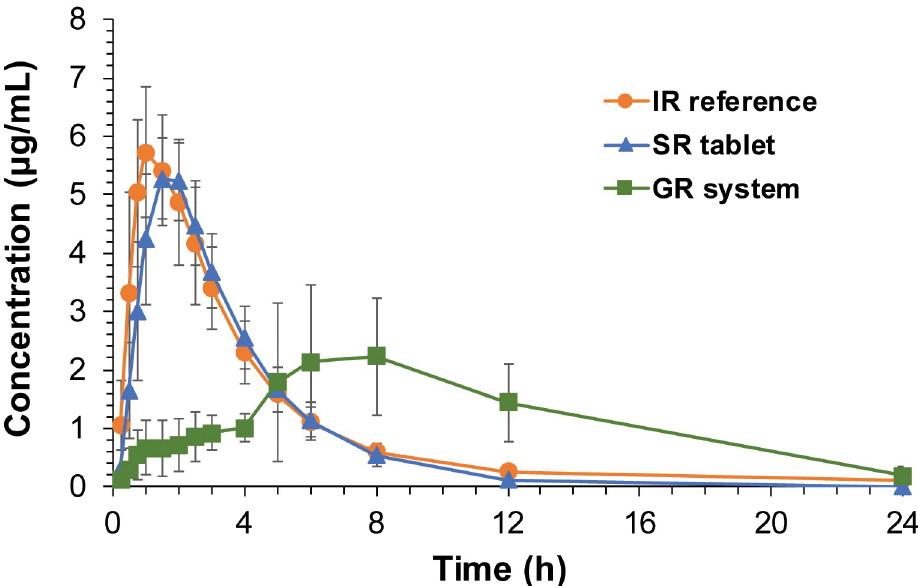
Fig 5. In vivo pharmacokinetics of the gastroretentive (GR) system in Beagle dogs. Plasma concentration vs. time profiles of acyclovir following oral administration of the immediate-release (IR), sustained-release (SR), or GR system of acyclovir in Beagle dogs. Data are presented mean ± SD (n = 5).